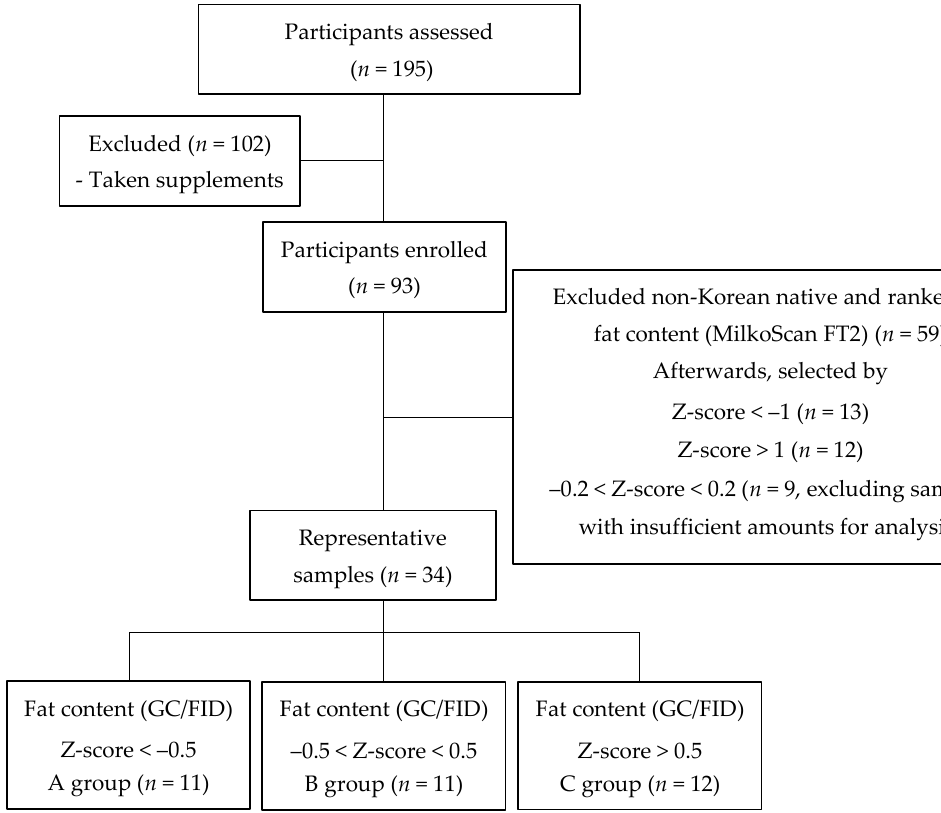
Figure 1. Study flow chart of sample collection.